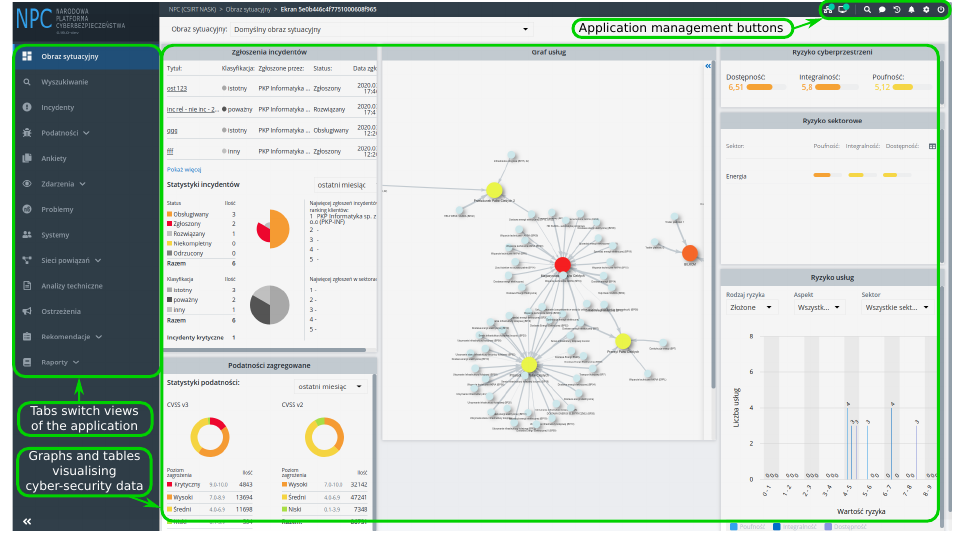
Figure 1. Example of a cybersecurity window. The menu tabs can be selected by either a computer mouse, or keyboard, while the graphs visualising data are scaled by touch screen